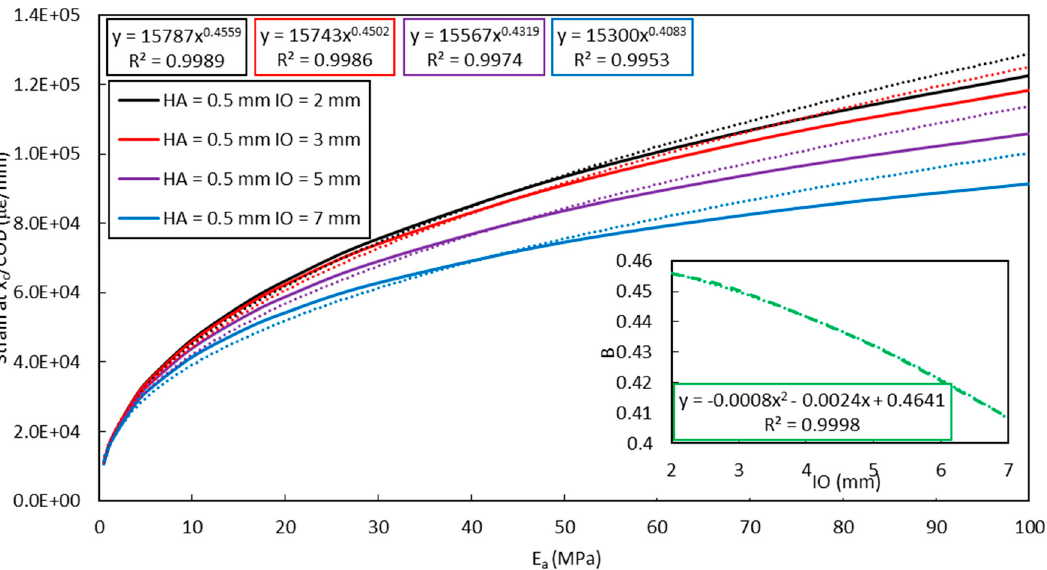
Figure 20. Evolution curves of the shear lag parameter (at x = x c ) versus the adhesive Young’s modulus E a , considering different IO values (FEM simulations in solid lines, exponential fitting in dotted lines). Dependence of parameter B on IO is also displayed as enclosed graph. Sensors 2020 , 20 , x FOR PEER REVIEW